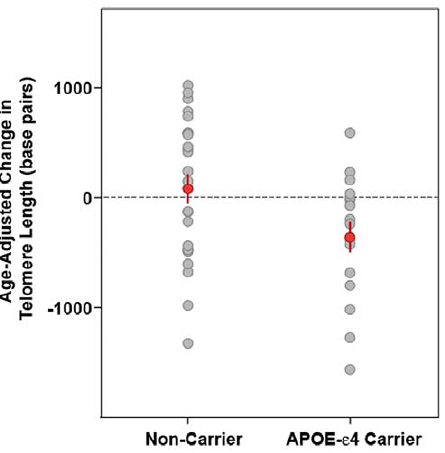
Figure 1. APOE- e 4 genotype and telomere attrition. Dot plot illustrating age-adjusted change in leukocyte telomere length (TL) in carriers of the APOE- e 4 risk allele and non-carrier controls. APOE- e 4 carriers had significantly greater age-adjusted LTL shortening over the 2 year study period than non-carrier control participants [ F (1,39) 4.89, p =.03]. T/S ratios using DNA samples from the human cell line IMR90 at different population doublings. The slope of the linear regression line through a plot of T/S ratio (the x axis) versus mean TRF length (the y axis) is the number of base pairs of telomeric DNA